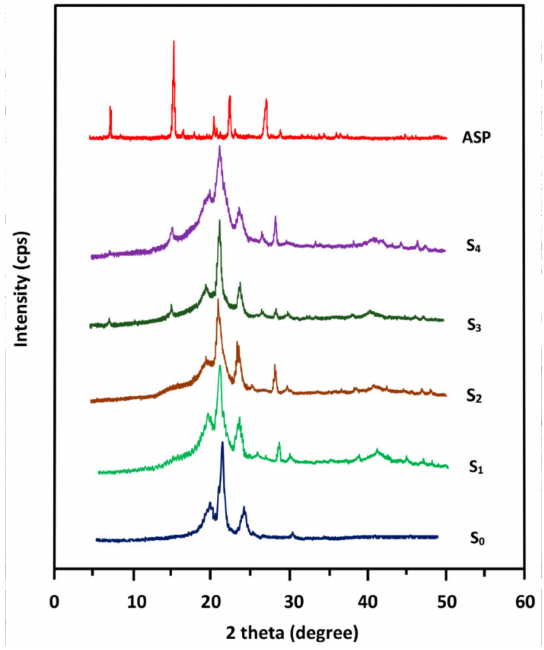
Figure 7. XRD patterns of PE- co -VAL/P δ -VL50 and ASP/PE- co -VAL/P δ -VL composites with different ASP loads: PE- co -VAL/P δ -VL (S 0 ); ASP-2/PE- co -VAL/P δ -VL (S 1 ); ASP-5/PE- co -VAL/P δ -VL (S 2 ); ASP-7/PE- co -VAL/P δ -VL (S 3 ), and ASP-10/PE- co -VAL/P δ -VL (S 4